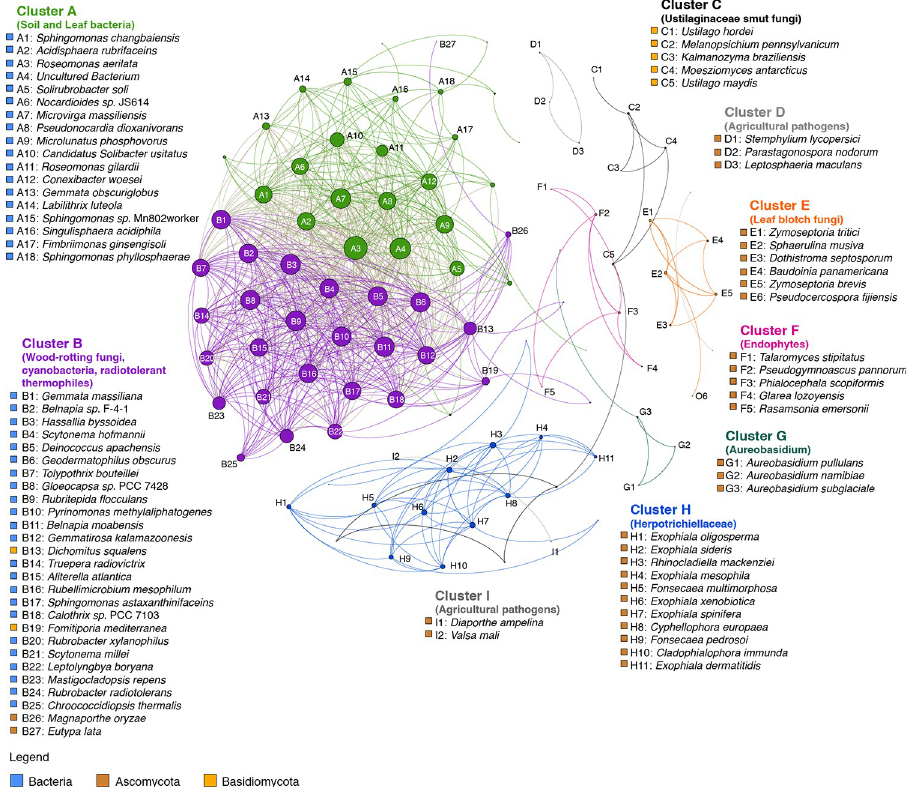
Fig 3. Co-occurrence network analysis of microorganisms on the adaxial and abaxial leaf surfaces. Of the nine clusters identified, two are highly interconnected (clusters A and B). Microorganisms in both clusters are highly abundant on the adaxial surface but are significantly reduced on the abaxial surface. Cluster A is composed of soil and leaf bacteria while cluster B comprises of wood-rotting fungi, photosynthetic cyanobacteria, thermophilic and radiation-tolerant bacteria. The nodes were selected with a cut-off of Spearman rank correlation coefficient of 0.8 and p -value of